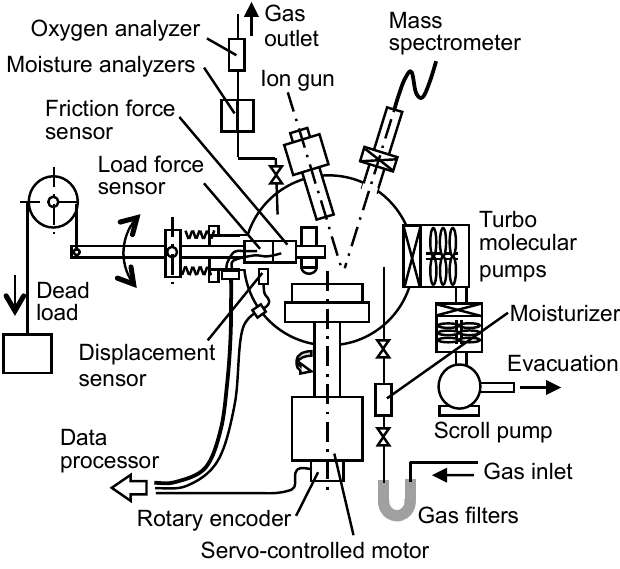
Figure 1. Pin-on-disk apparatus with an advanced gas control system.